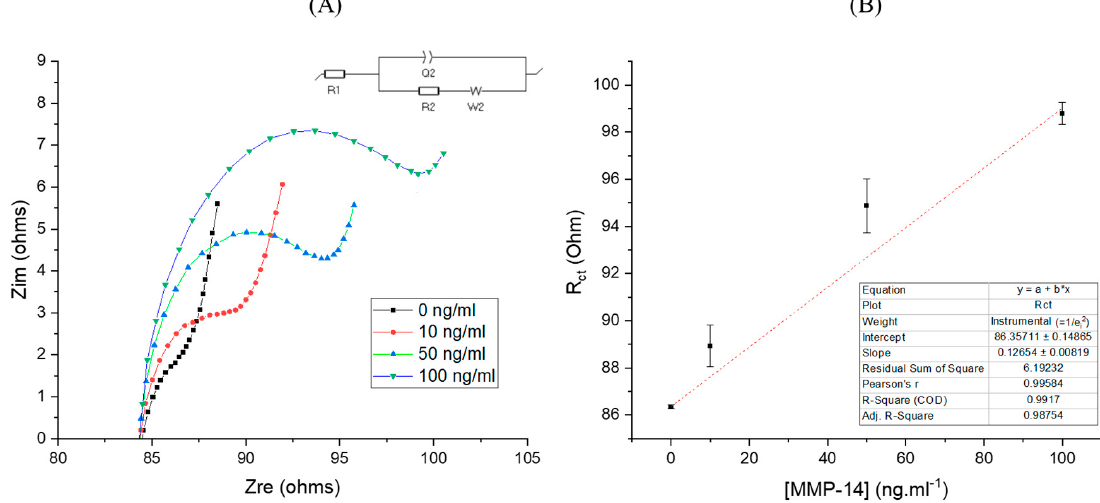
Figure 3. ( A ) Nyquist plots of inhibitor loaded CNTs before and after interaction with different concentrations of MPP-14 for 10 minutes in PBS (pH 7.40) containing 10 mmol.mL − 1 of K 3 [Fe (CN) 6 ] − and 10 mmol.mL − 1 of NaCl. ( B ) Linear fit of EIS response for different concentrations of MMP-14, presenting LOD of 7.5 ng · mL − 1 . Significant difference between measurements was obtained at p -value < 0.05 (n = 2). Protein concentration varying from 10 ng.mL − 1 to 100 ng.mL − 1 , applied potential of +0.20 V, from 50 kHz to 500 Hz, amplitude 50 mV.